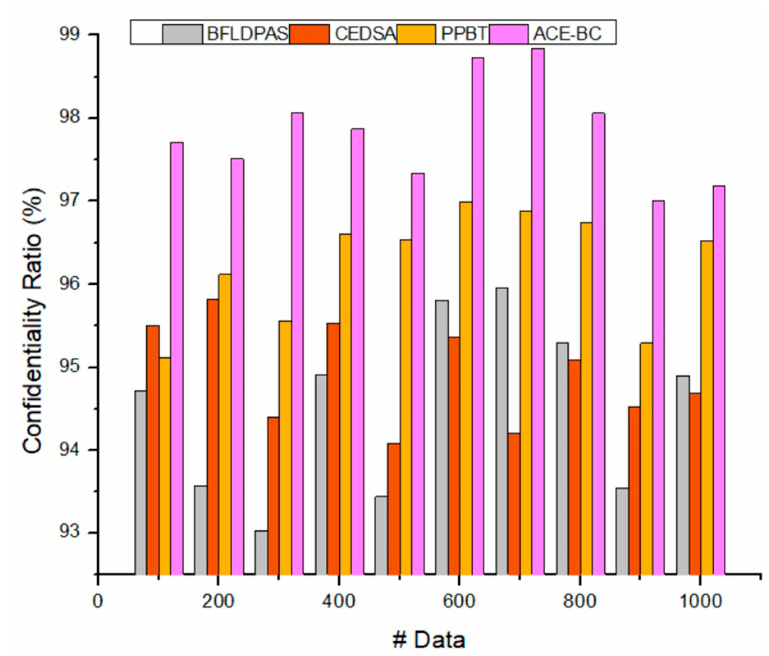
Figure 5. Data confidentiality ratio.